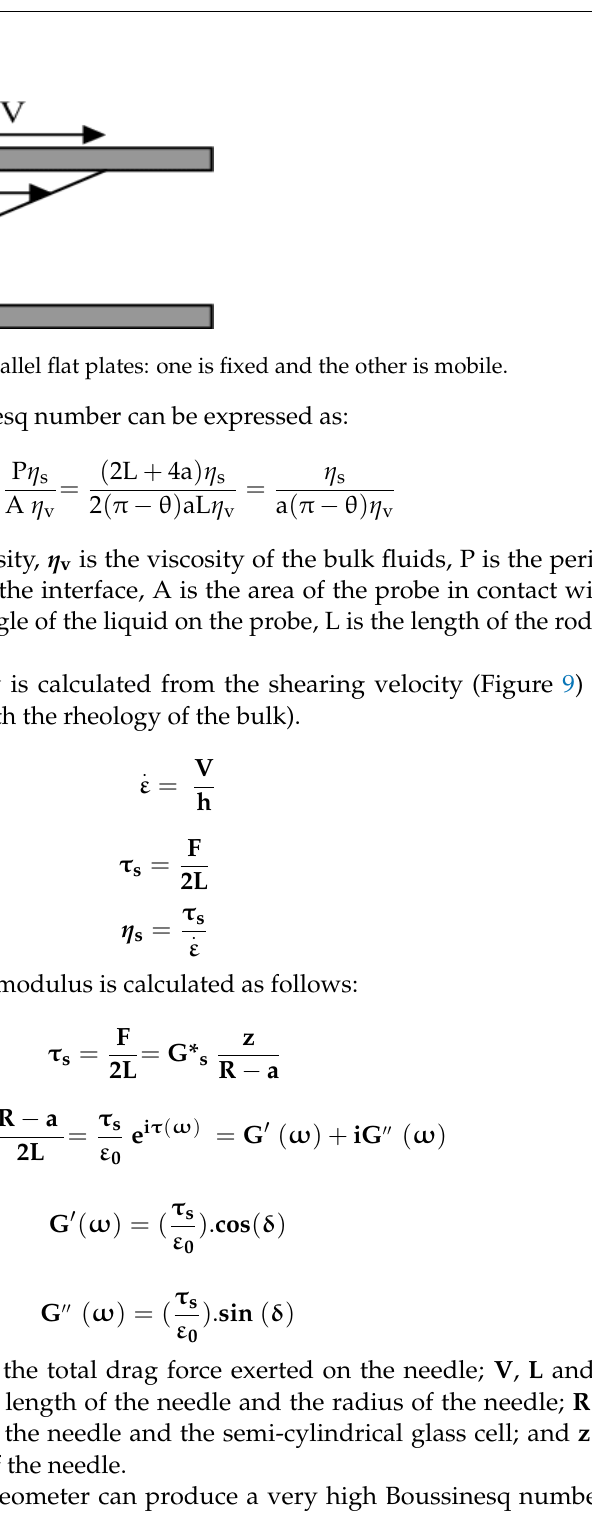
11 of 39 Figure 8. Schematic diagram of the oscillating needle device used for interfacial rheology. The first oscillating needle was manufactured by Plateau [15]. Currently, it is marketed under the name of the Interfacial Shear Rheometer (ISR) (Figure 9). It can operate in two different modes: the static or harmonic regime. In this case, the Boussinesq number can be expressed as: Bo = P ɳ s A ɳ v = ( 2L + 4a ) ɳ s 2 ( п-θ ) aL ɳ v =